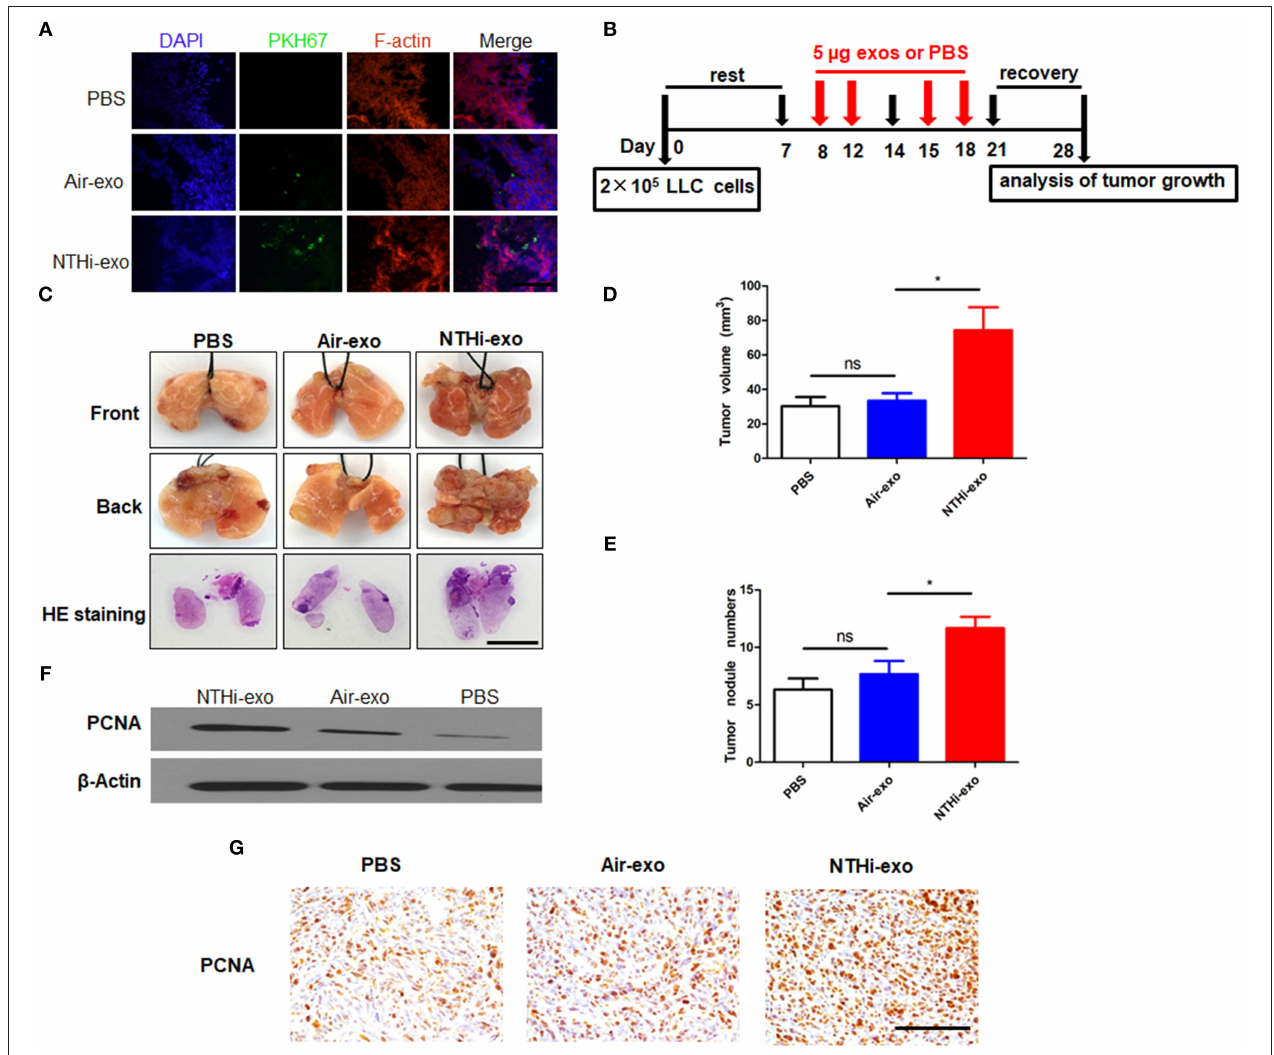
FIGURE 7 | NTHi-Exos promote tumor growth in vivo . (A) Tumor cells demonstrated uptake ofPKH-67 labeled exosomes from the BALF. Scar bar = 100 µ m. (B) Scheme of experimental protocols for animal experiment. (C) Microscopic and macroscopic analysis of lung cancer after injection of exosomes or PBS control ( n = 5) Scar bar = 100 µ m. (D–E) Lung tumor nodules and volume detectable on the surface were determined. (F) Western blotting analysis of PCNA protein levels in excised lung tumors treated with NTHi-Exos, air-Exos, and PBS control. (G) Immunohistochemical analysis of PCNA protein levels in tumor tissues. Scar bar = 200 µ m. Results are presented as means ± SEM of three independent experiments. * P <